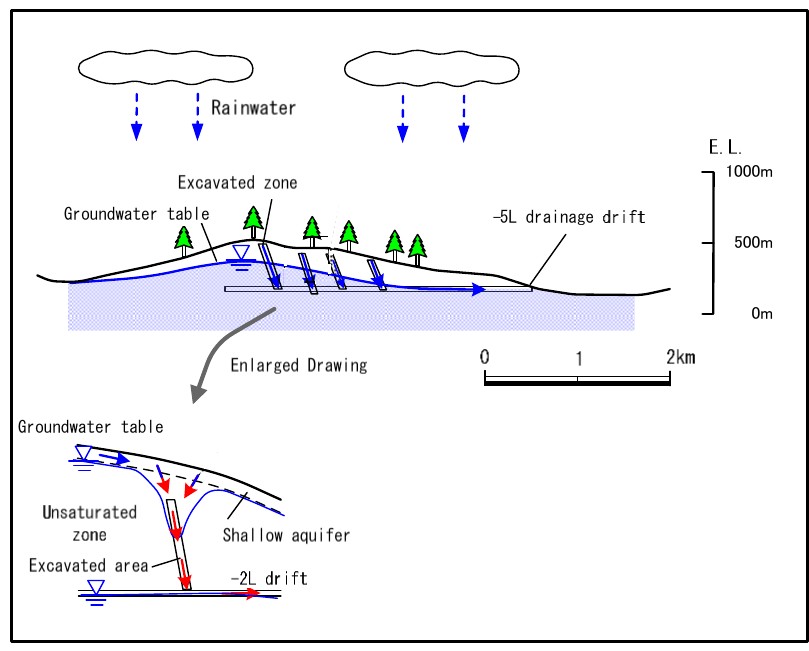
Figure 2. Illustration of the groundwater flow regime.